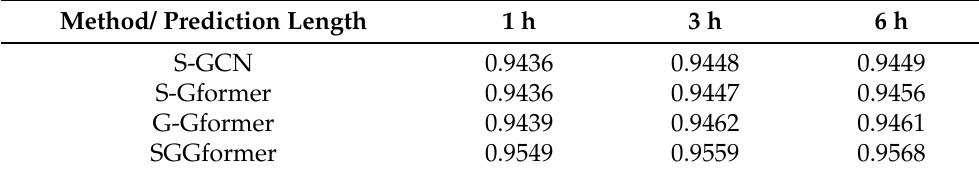
Table 5. The ablation analysis on quadratic-weighted kappa